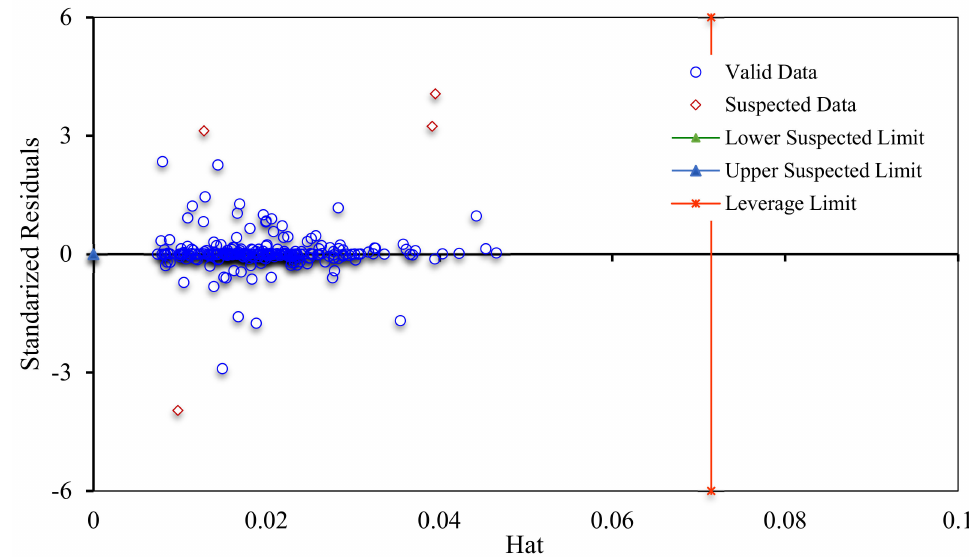
Figure 15. William’s plot for determining the applicability domain and suspected data points of asphaltenes adsorption onto